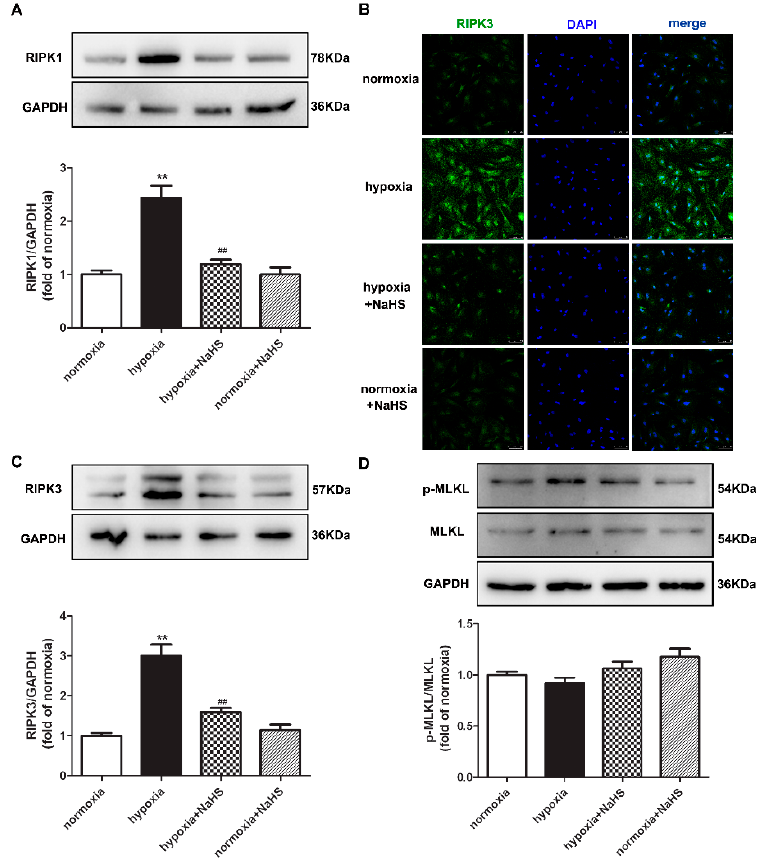
Figure 6. NaHS attenuated necroptosis in cardiac fibroblasts with hypoxia. After pre-administration with NaHS (50 μ M) for 4 h, neonatal rat cardiac fibroblasts were subjected to normoxia (containing 5% CO 2 and 95% O 2 ) or hypoxia (containing 5% CO 2 and 1% O 2 ) for 4 h. ( A ) The RIPK1 protein expression was detected by Western blot. ( B ) RIPK3 was immunofluorescence stained with Alexa Fluor 488 (green) conjugated IgG. The nuclei were stained with DAPI (blue). Bar = 75 μ m. ( C , D ) The RIPK3 and MLKL protein expressions were detected by Western blot. ** p < 0.01 vs. normoxia, ## p < 0.01 vs. hypoxia, n = 6.